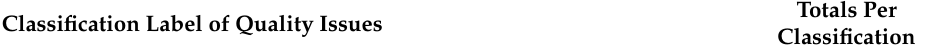
Table A3. Number of quality issues and their classification for CTs assessed and authorized from 2018 to